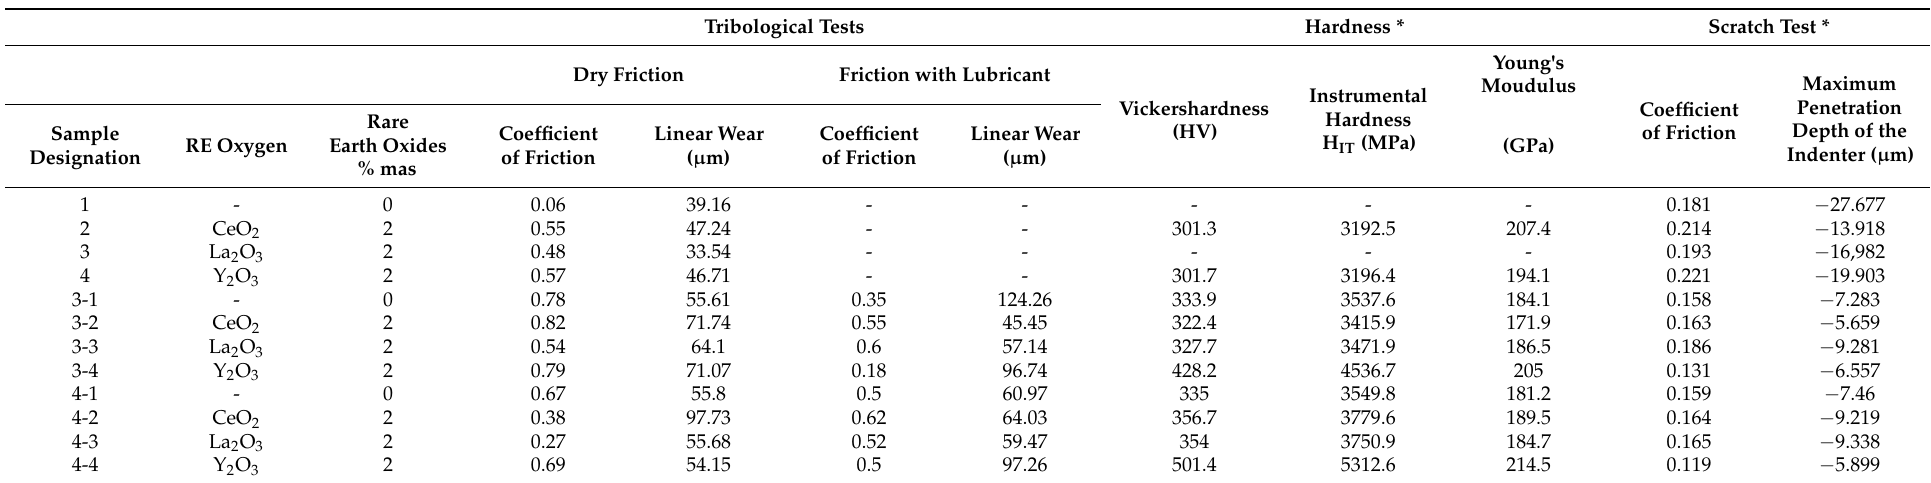
Table 1. Compilation of sample test